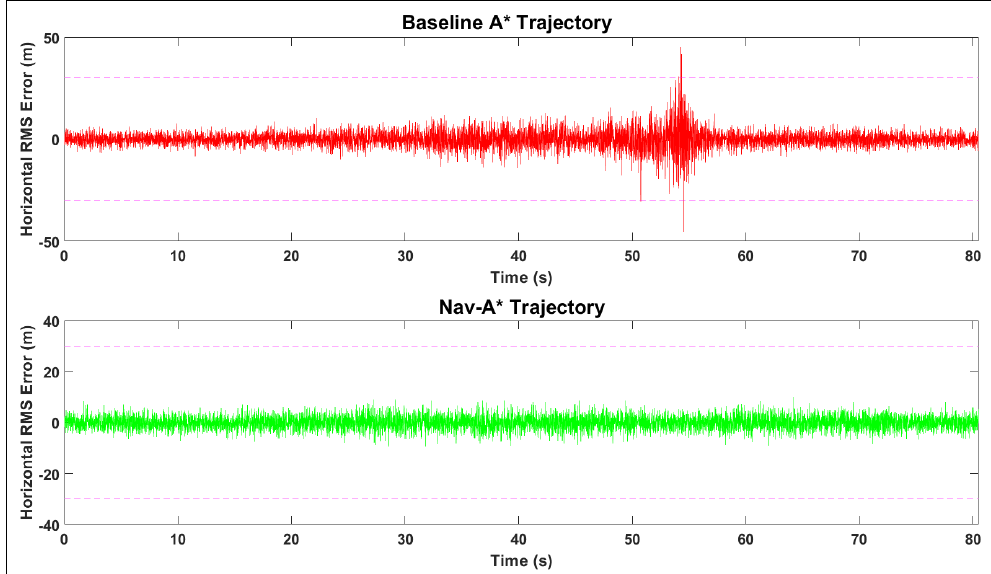
Figure 12. HRMS error time-series (Dual-frequency).